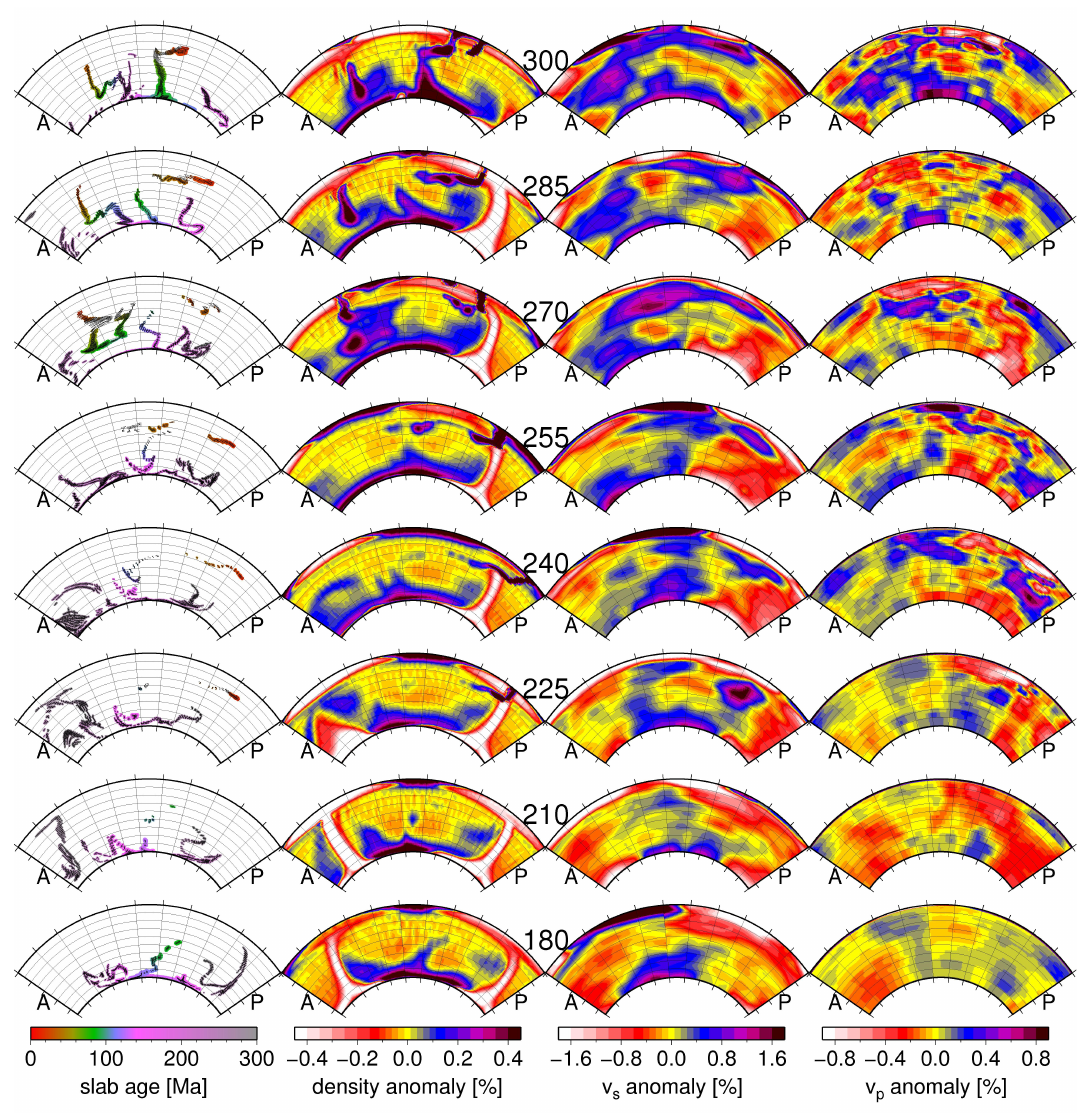
Fig. 6b. Part (C) : Cross sections beneath Southern Asia, Australia and Antarctica (north to south from top to bottom